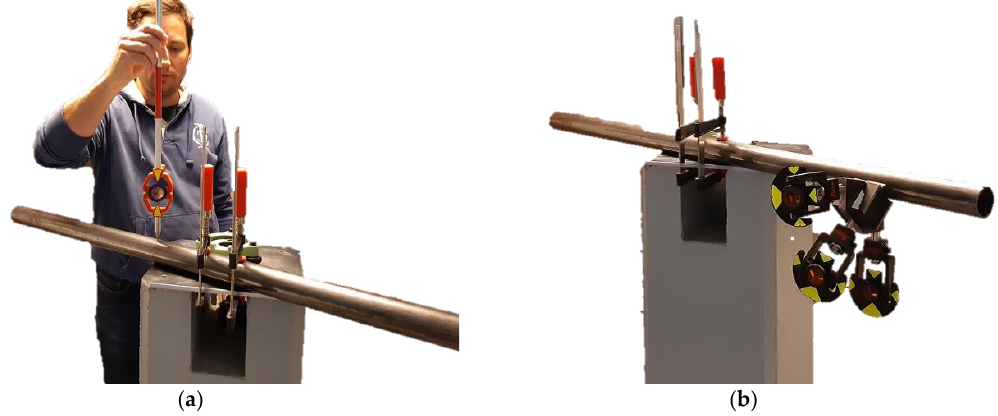
Figure 8. Measurement in a laboratory: ( a ) single-prism; ( b ) new platform.